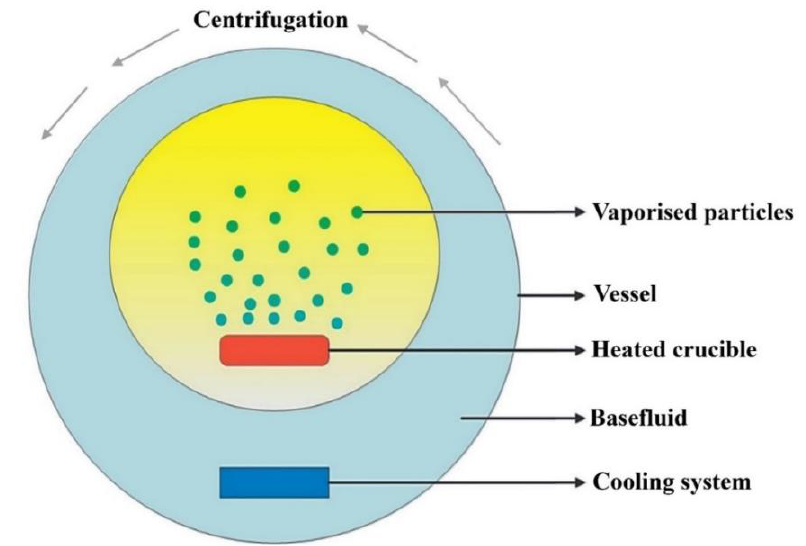
Figure 9. Eastman et al. [21] one-step method of evaporation and centrifugation for nanofluids fabrication [37].